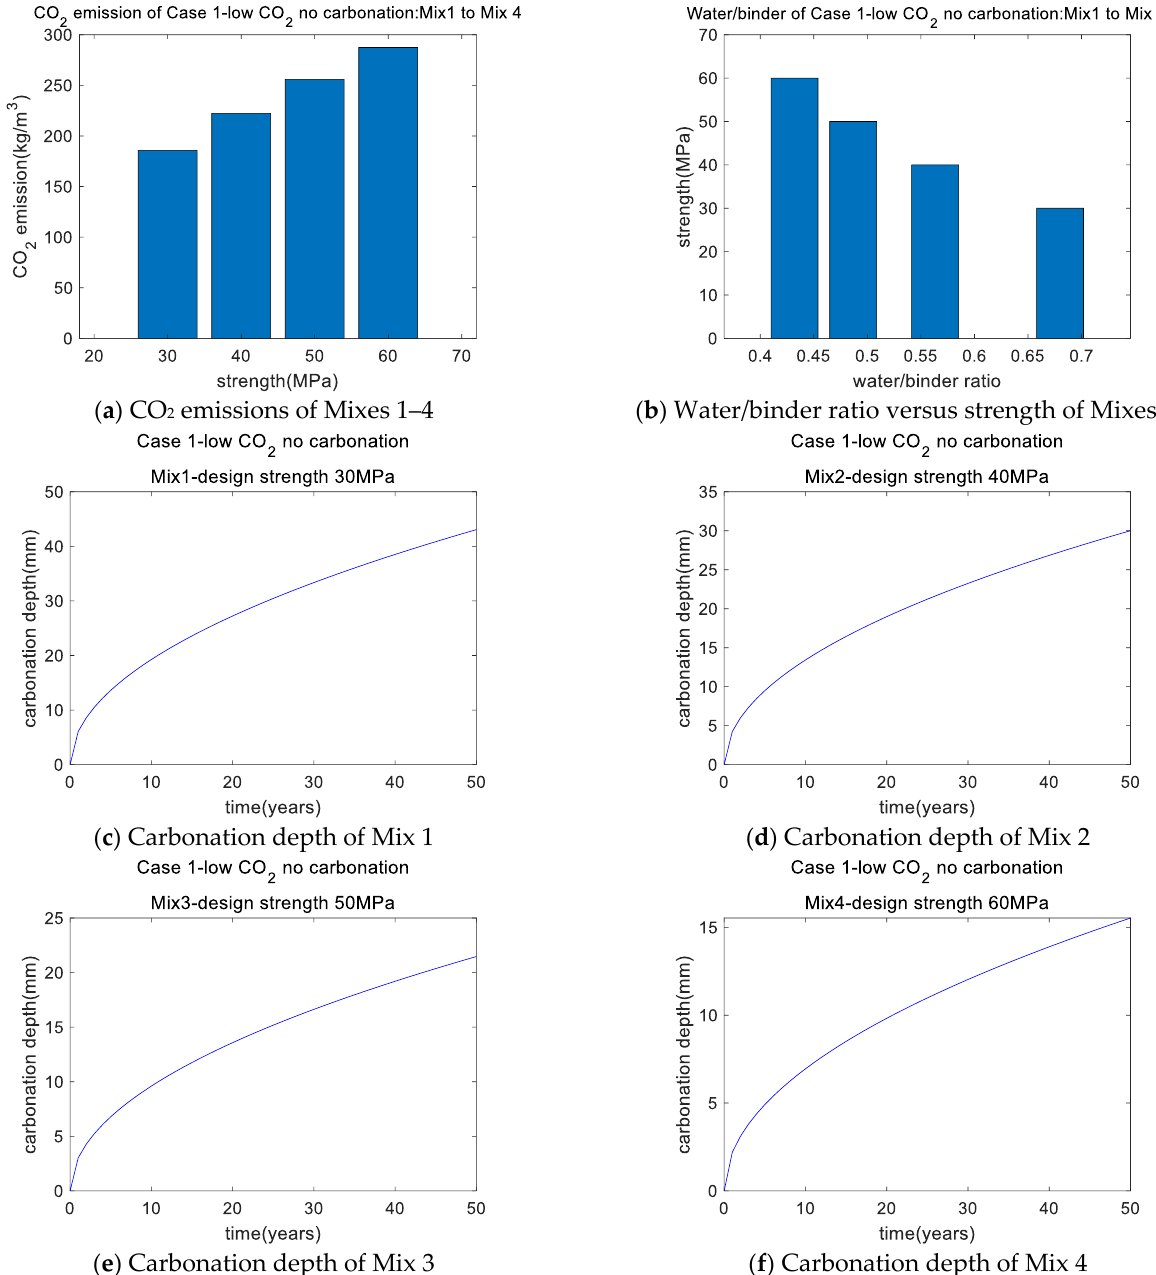
Figure 2. Performance of Case 1: Mixes 1 – 4 (low CO 2 without carbonation).